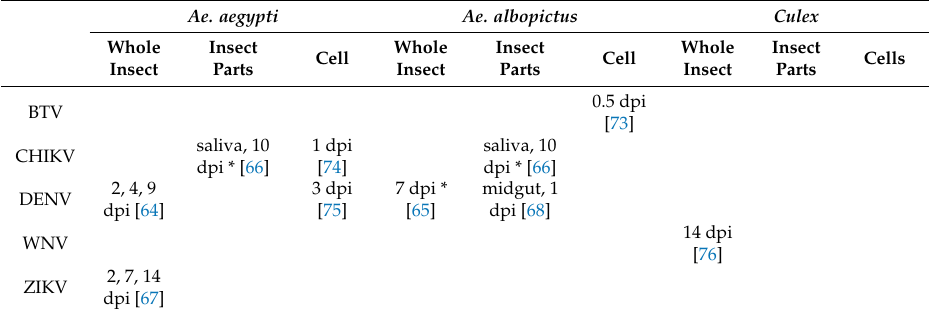
Table 1. Summary of miRNA profile change studies in insect-arbovirus